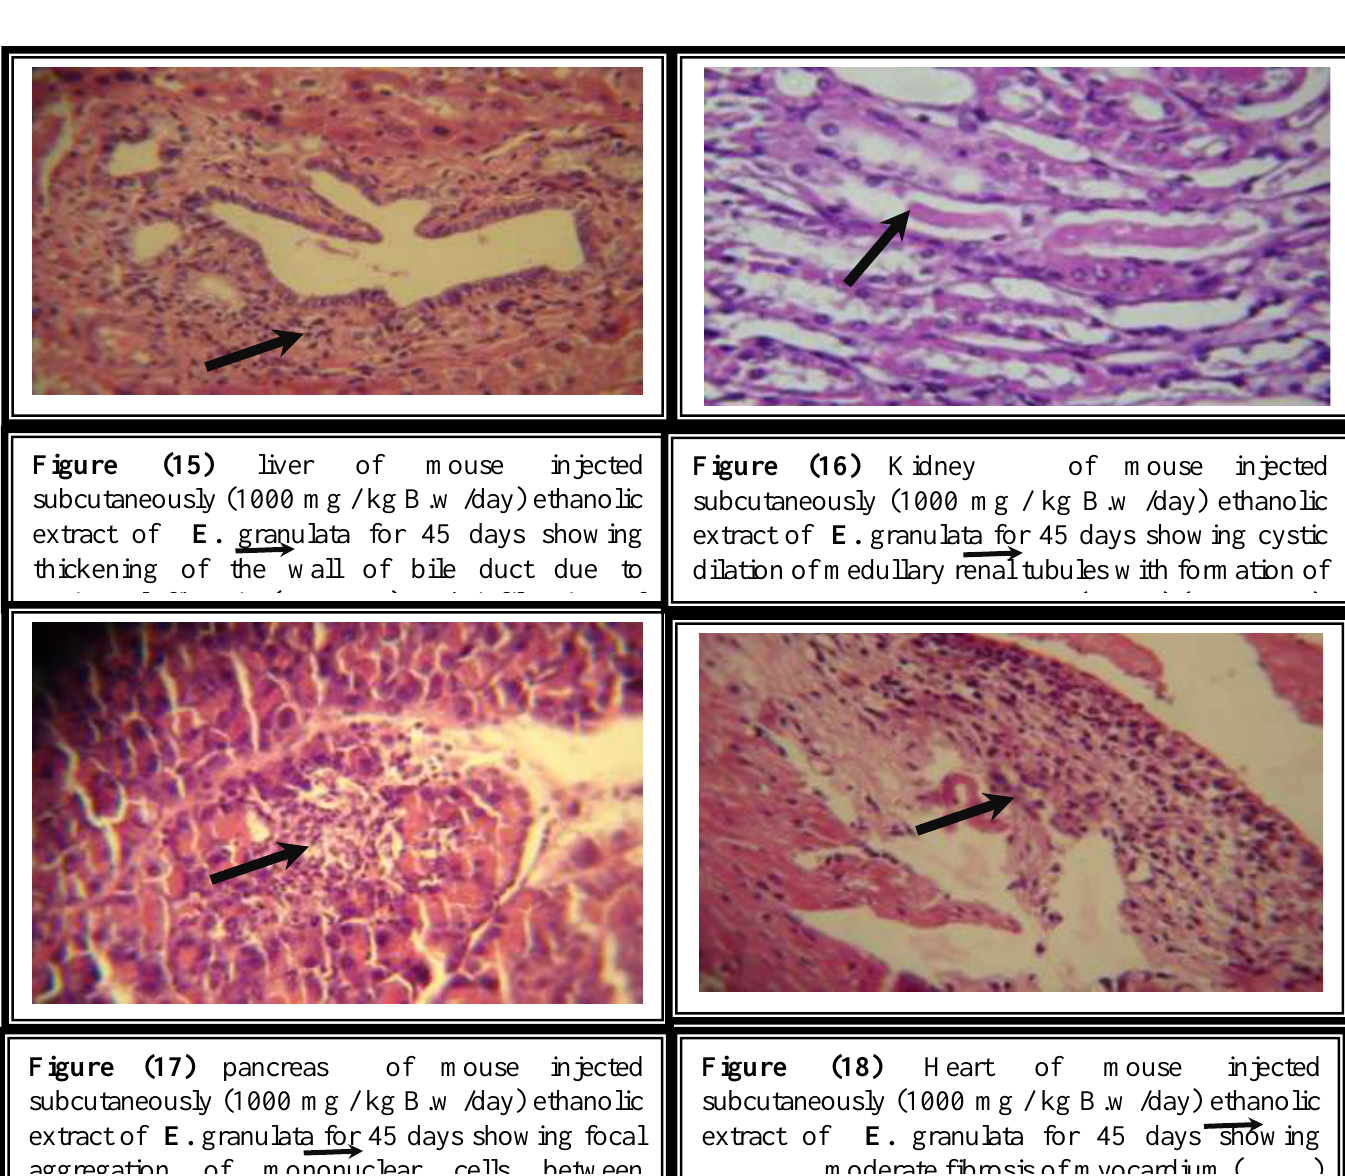
Figure (17) pancreas of mouse injected Figure (18) Heart of mouse injected subcutaneously (1000 mg / kg B.w /day) ethanolic subcutaneously (1000 mg / kg B.w /day) ethanolic extract of E. granulata for 45 days showing focal extract of E. granulata for 45 days showing 114 aggregation of mononuclear cells between moderate fibrosis of myocardium ( ) pancreatic acini ( ) (H&Ex400). with infiltration of mononuclear cells